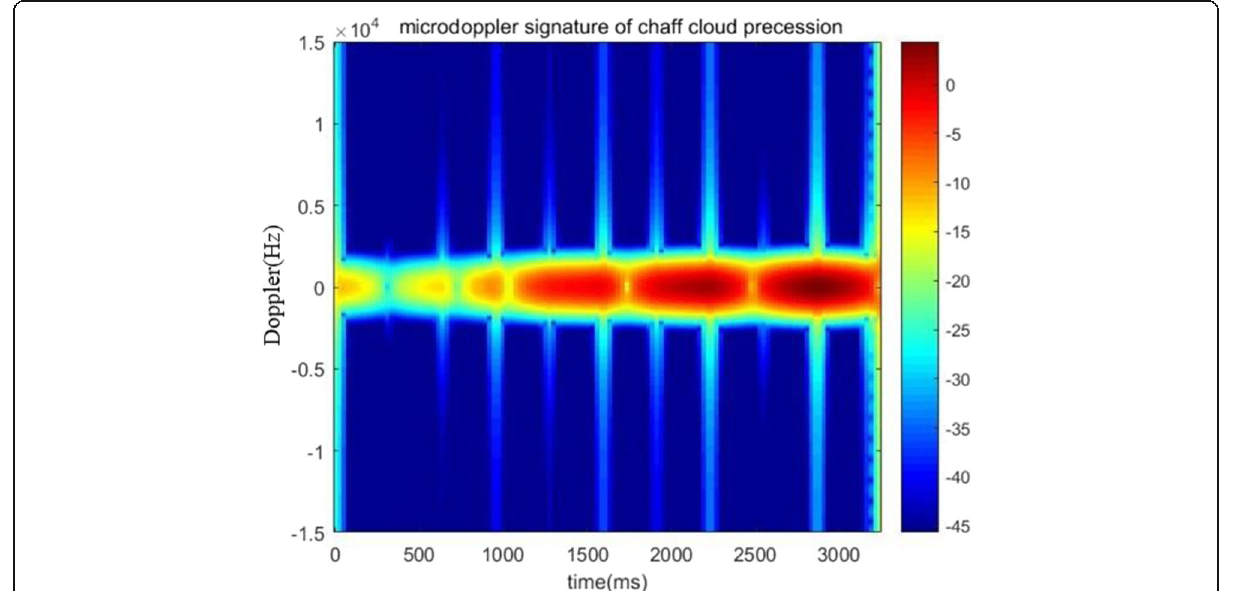
Fig. 16 Time-frequency signatures of the precession from the chaff